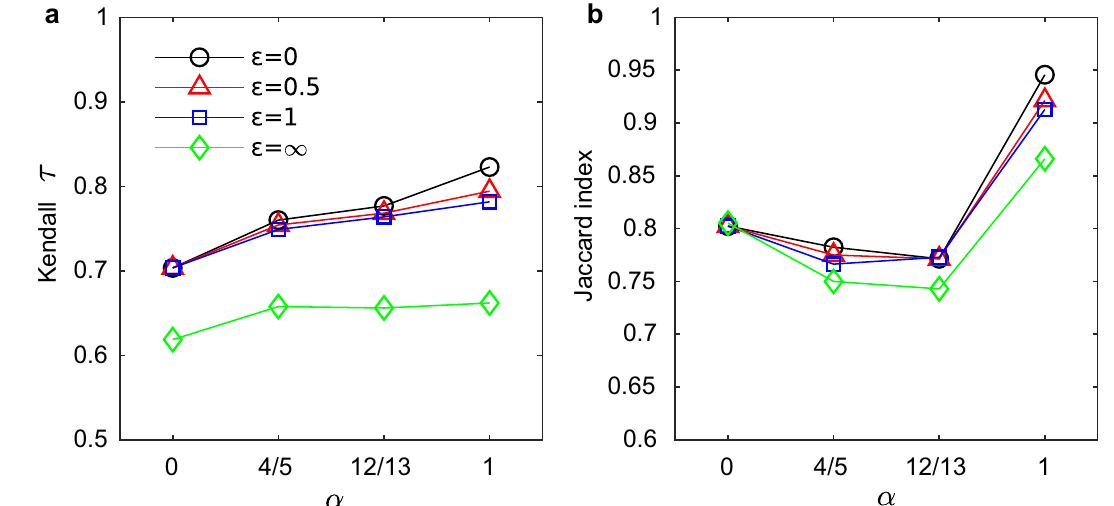
Figure 2. Comparison between the results obtained with the proposed betweenness centrality and with static betweenness centrality computed on the aggregated network obtained with method (i), for different values of the parameters α and ε . ( a ) Correlation between the rankings; ( b ) Jaccard index between the sets of airports with zero-betweenness according to both